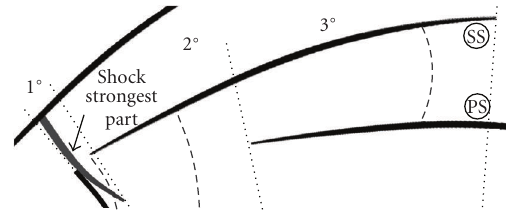
Figure 13: Sketch of the α + wave development.